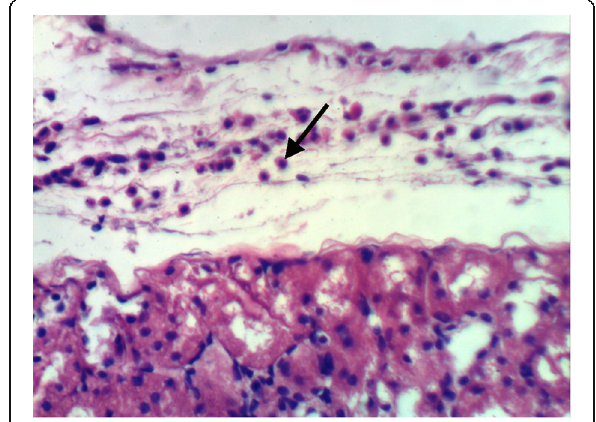
Fig. 6 Photomicrograph of rat ’ s testis fed the balanced diet supplemented with taurine +oral pot.bromate, showing markedly decreased number of germ cells. (H&E ×400)